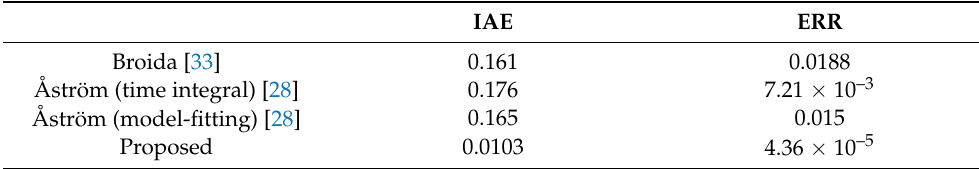
Figure 15. The Bode plots for process G P3 . Table 7. The criteria values for the process G P3